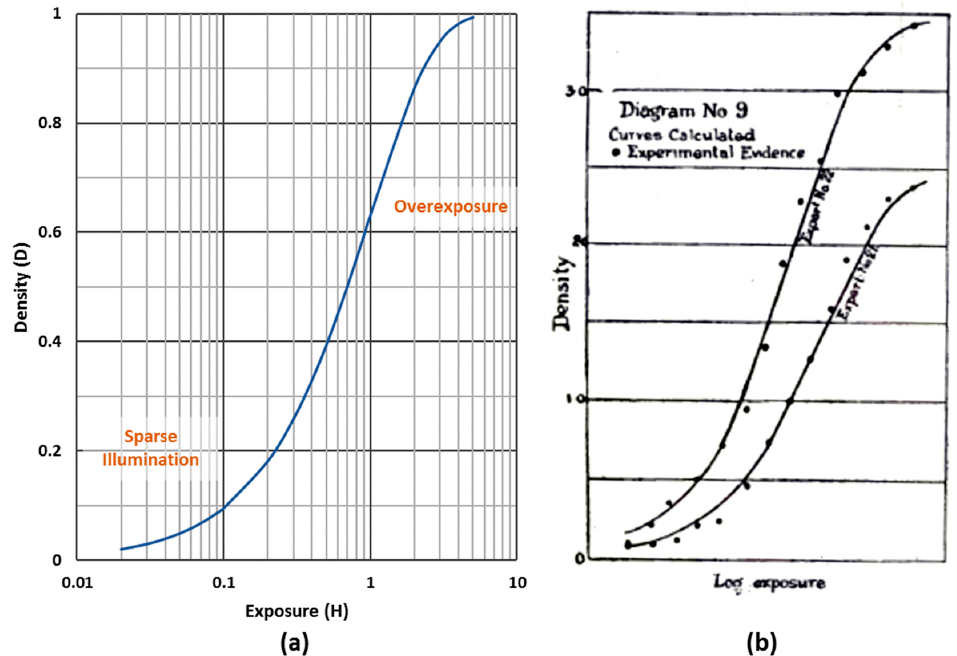
Figure 3. ( a ) Single-bit QIS bit density as a function of quanta exposure, in D -log( H ) format. Sparse and over exposure regions are labelled [9]; ( b ) D -log( H ) curve for photographic plates as reported by Hurter and Driffield in 1890 [37].